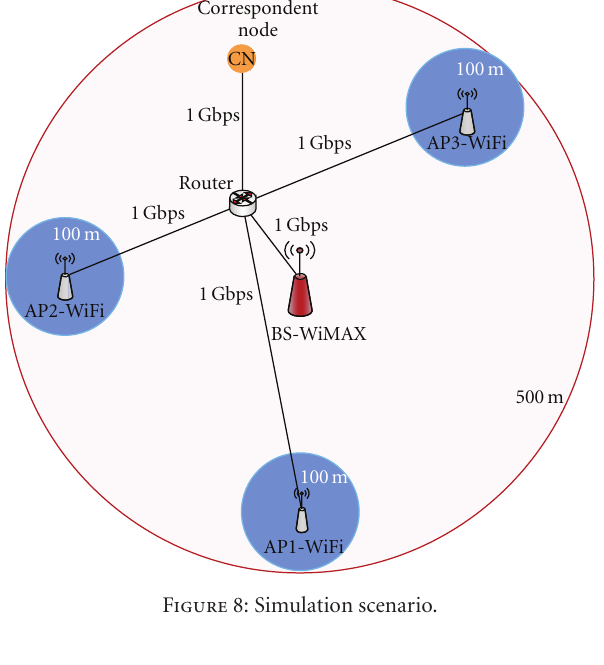
Figure 8: Simulation scenario.